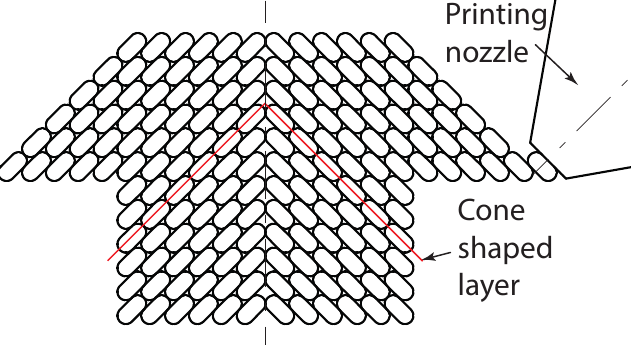
Figure 1. Printing strategy with the cone shaped